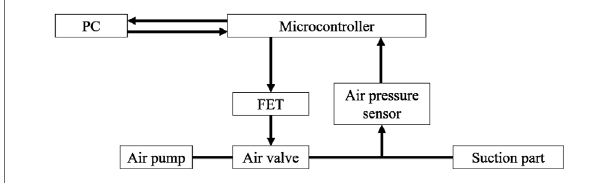
FIGURE 2 | Block diagram of the suction system. The PC sends the target air pressure value to the microcontroller. The microcontroller continuously compares the air pressure sensor value with the target air pressure value and controls suction by opening and closing valves using